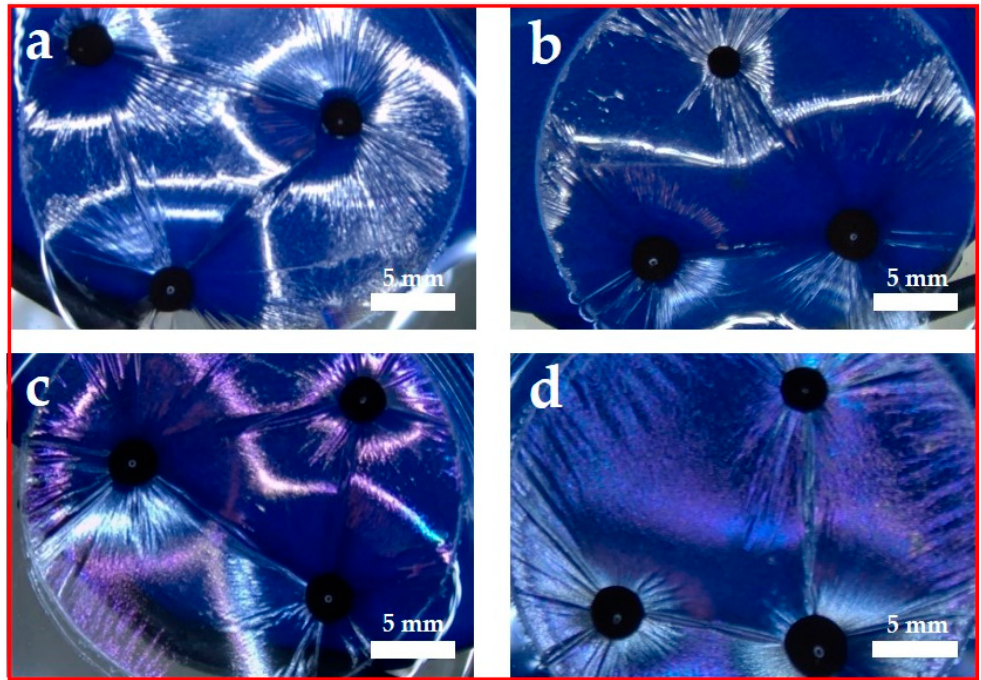
Figure 5. Optical microscopy images of surface morphologies on the floating PS film with three magnetic droplets on it. Three 4 μ L magnetic droplets were placed on a PS film of ( a ) 100 nm and magnetic droplets on it. Three 4 µ L magnetic droplets were placed on a PS film of ( a ) 100 nm and ( c ) 200 nm thick. Three magnetic droplets with the volumes of 2 μ L, 4 μ L, and 6 μ L are placed on a ( c ) 200 nm thick. Three magnetic droplets with the volumes of 2 µ L, 4 µ L, and 6 µ L are placed on a PS film of ( b ) 100 nm and ( d ) 200 nm thick. PS film of ( b ) 100 nm and ( d ) 200 nm